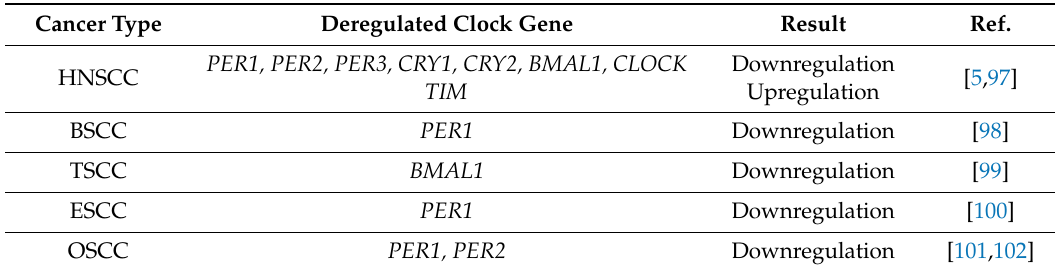
Table 2. Association of circadian clock genes in